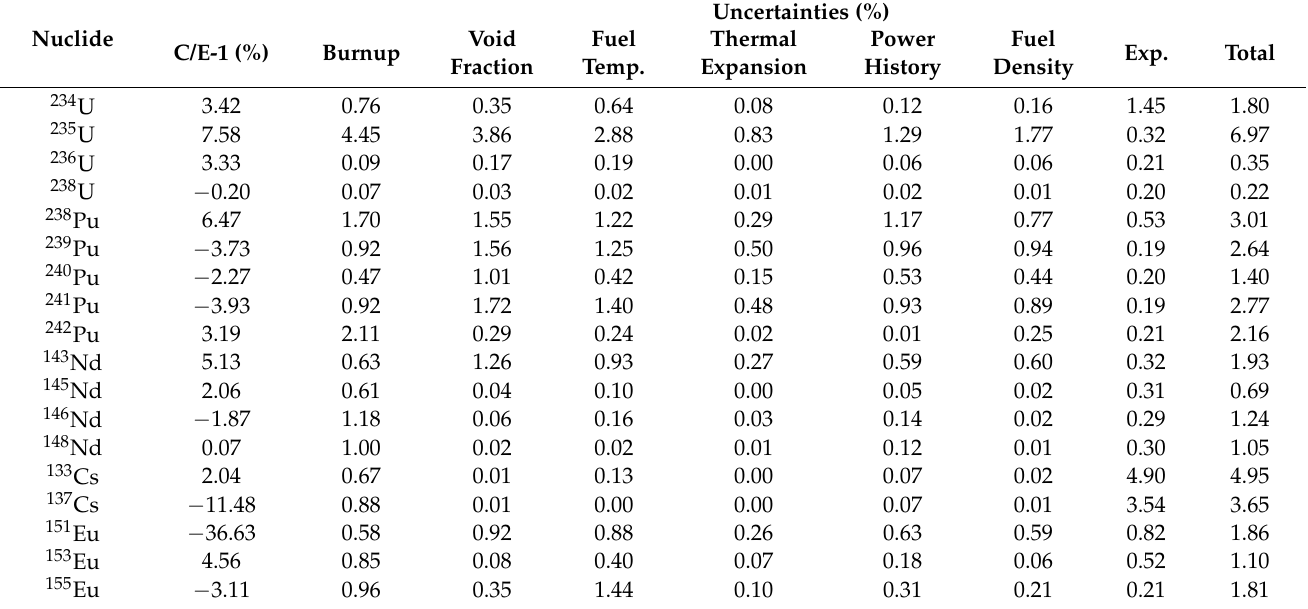
Table 5. C/E-1 (%) and uncertainties for sample 2F1ZN3-C3-UM (68.4